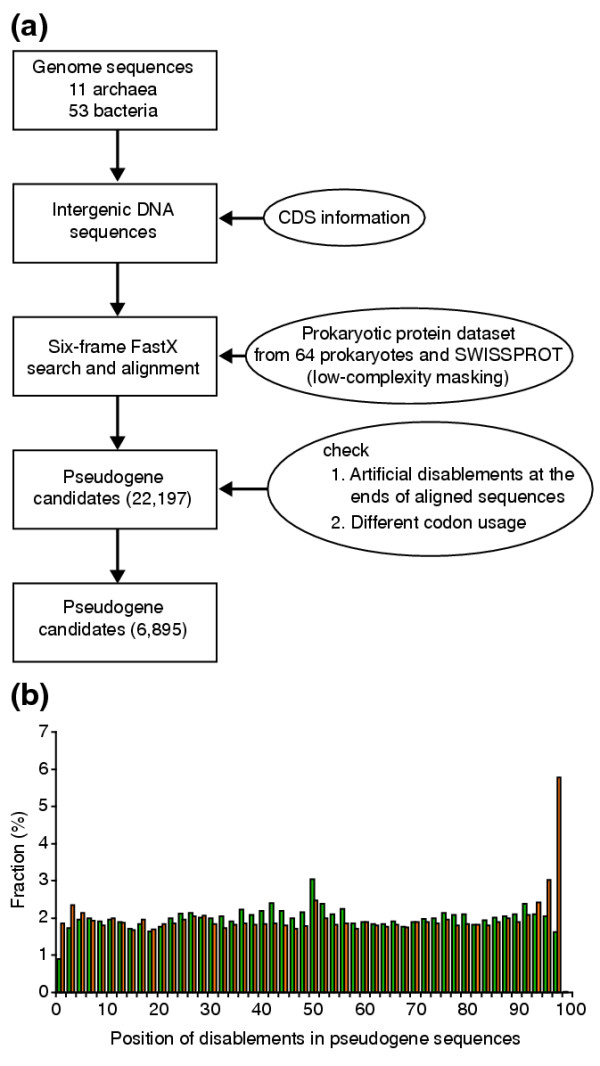
Pseudogenes in prokaryotes. (a) Procedure for assigning pseudogenes. The flow chart shows the steps in identifying pseudogenes in 64 prokaryote genomes. The steps include: separate intergenic regions from coding sequence (hypothetical ORFs were excluded); six-frame FastX search on intergenic regions for pseudogene candidates; quality control to reduce false-positive results introduced by artificial disablement or by different codon usage. (b) The occurrence of relative disablement positions in pseudogenes, which were normalized on a 100-residue scale based on ratios of the distances from starting residues to disablements to the length of pseudogenes. The yellow bars indicate the distribution of disablement positions before the last quality-control step and the green bars show the distribution after minimizing false-positive pseudogenes.